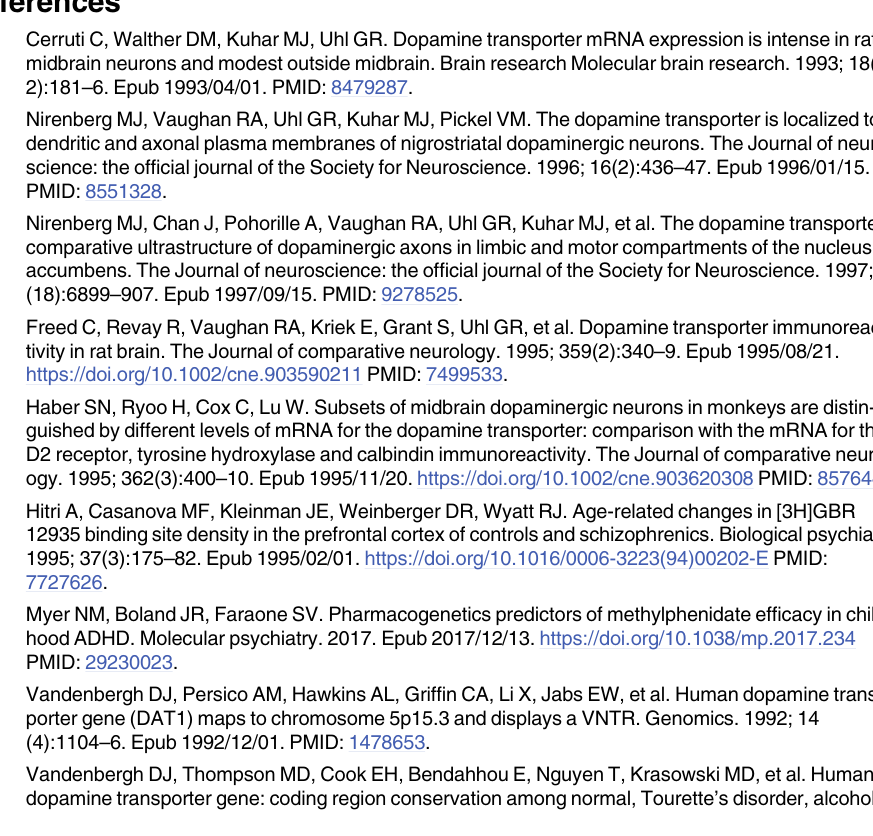
S2 Table. Common and unique alleles in COGA